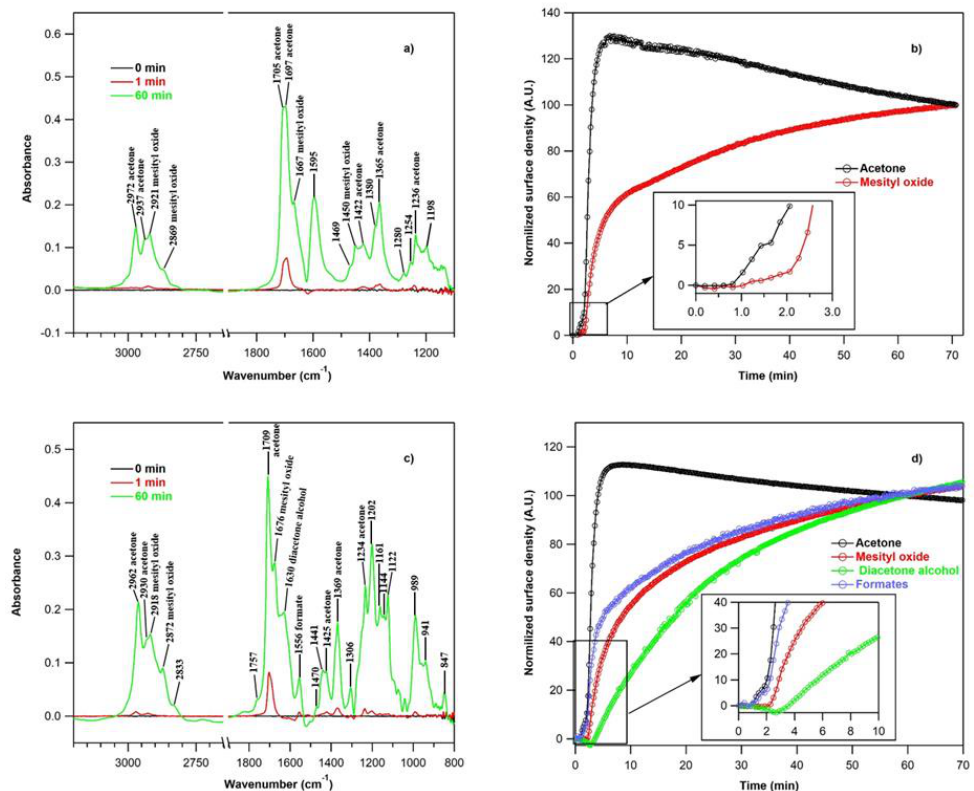
Figure 2. DRIFT monitoring of acetone uptake and TiO 2 and CeO 2 (200 ppm acetone, 250 mL/min 20% O 2 in Ar, 294 K): ( a ) DRIFT absorbance spectra recorded during acetone uptake on TiO 2 . ( b ) Temporal profiles of acetone and mesityl oxide (MO) adsorbed on the surface of TiO 2 during the uptake of acetone. ( c ) DRIFT absorbance spectra recorded during acetone uptake on CeO 2 . ( d ) Temporal profiles of adsorbed acetone, MO, formates and diacetone alcohol (DAA) on the surface of CeO 2 during the uptake of acetone.